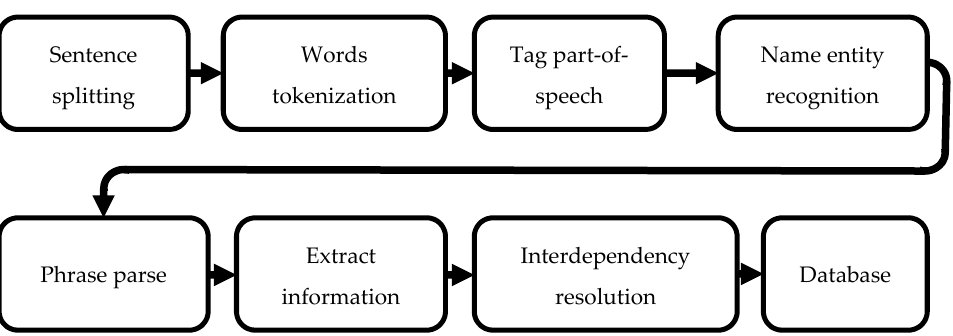
Figure 1. Standard natural language preprocess for text mining.